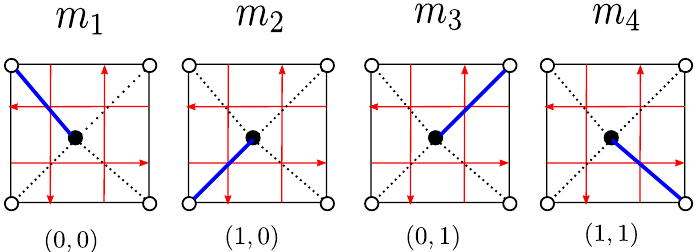
Figure 12. Perfect matchings of conifold geometry. Each lattice point of the toric diagram is a corner divisor and thus has a unique perfect matching. We denote the perfect matching as m corner divisor p , where i = 1 , 2 , 3 , 4 . We note m i